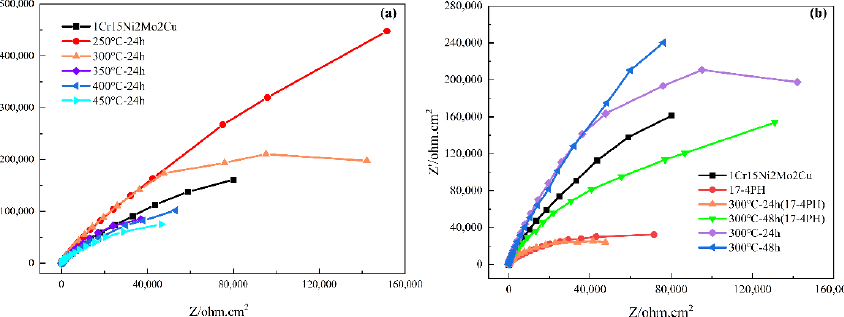
Figure 12. Nyquist impedance spectra of ( a ) 1Cr15 stainless steel at different nitriding temperatures and ( b ) 1Cr15 and 17-4PH stainless steel at different nitriding times.